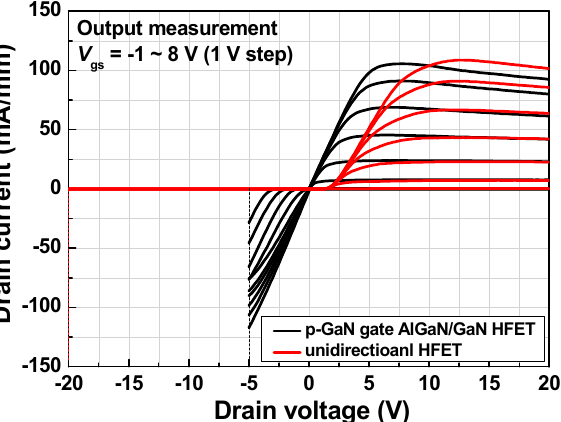
Figure 8. Output current–voltage characteristics of fabricated p-GaN gate AlGaN/GaN HFET (black line) and unidirectional HFET (red line).